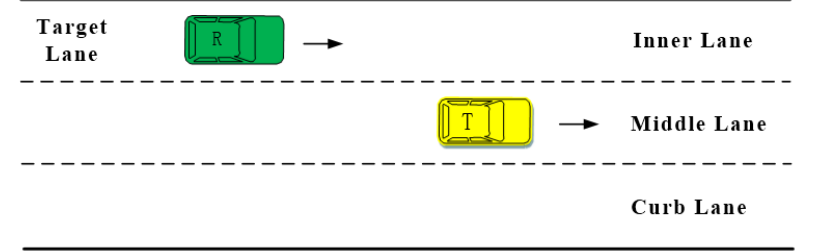
Figure 4. Rear extreme moment trial.